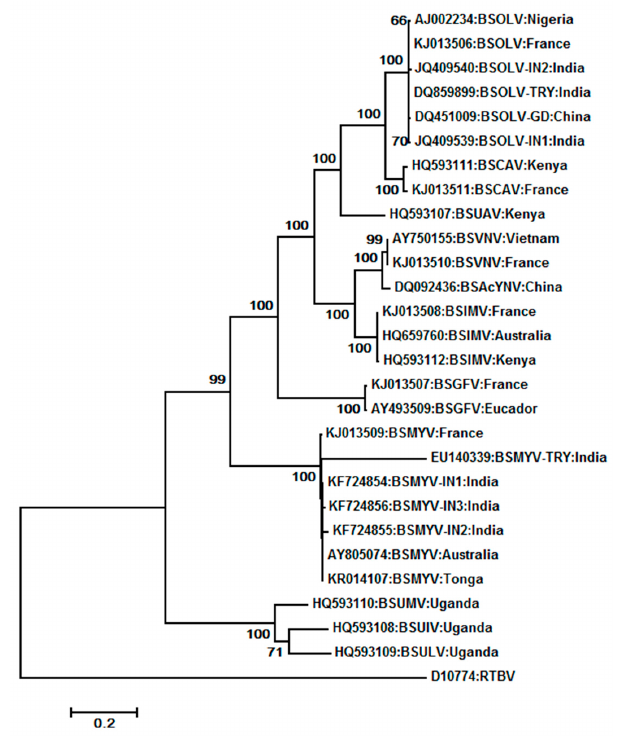
Figure 7. Phylogenetic clustering of 27 isolates belonging to different species of BSV based on amino acid sequence of open reading frame III. Acronyms used for viruses areprovided in Table S1. RTBV ( Rice tungro bacilliform virus ) was used as the outgroup.